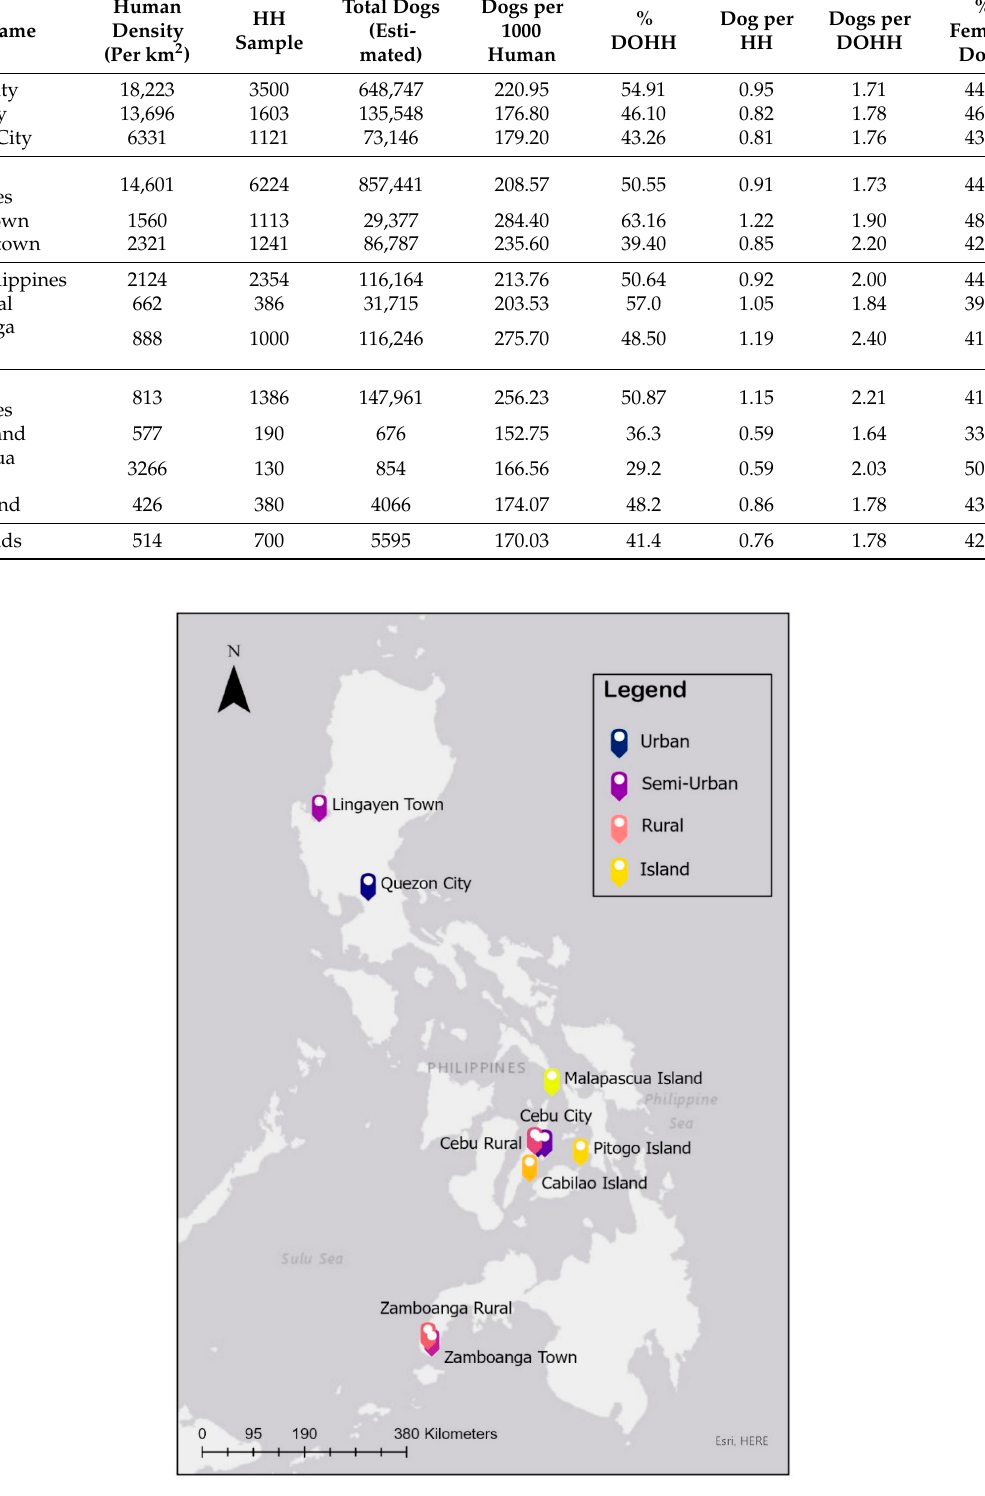
Figure 2. Arc GIS map of household survey locations in the Philippines; colour coded for four different